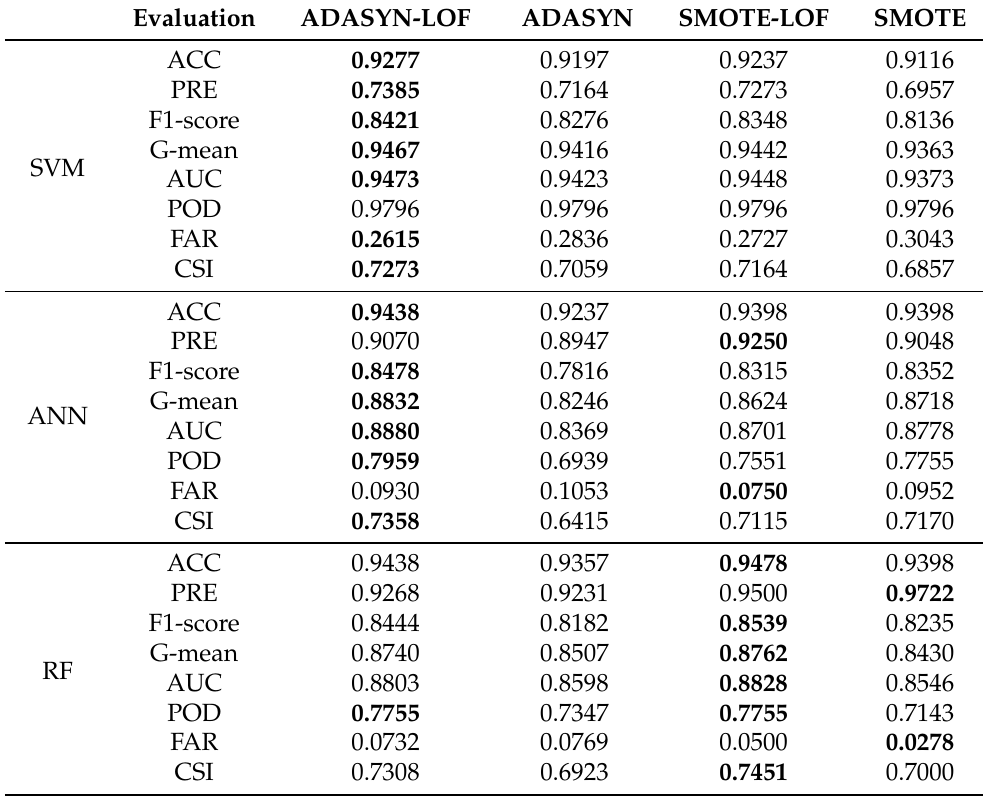
Table A2. The performance of ADASYN-LOF, ADASYN, SMOTE-LOF, SMOTE